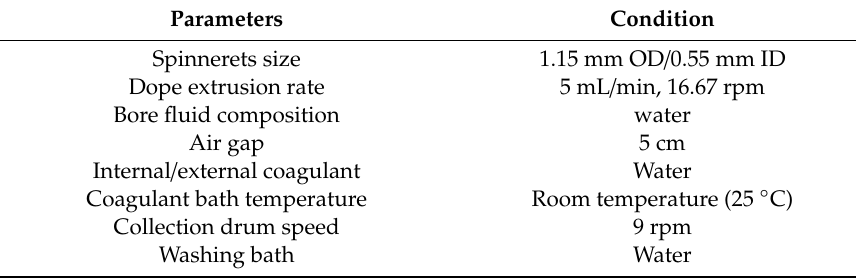
Table 2. Spinning